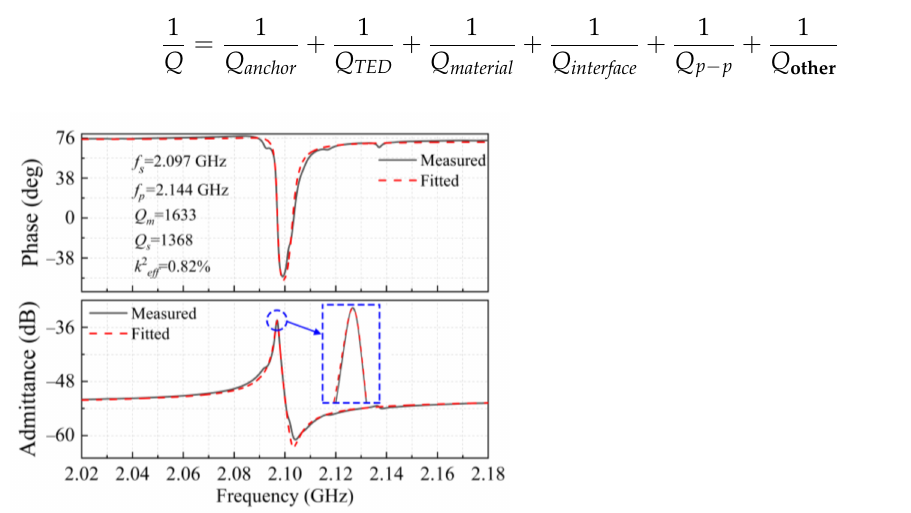
Figure 7. The measured and fitted admittance diagram and phase diagram for the LWR with the IDT period of 2 µ